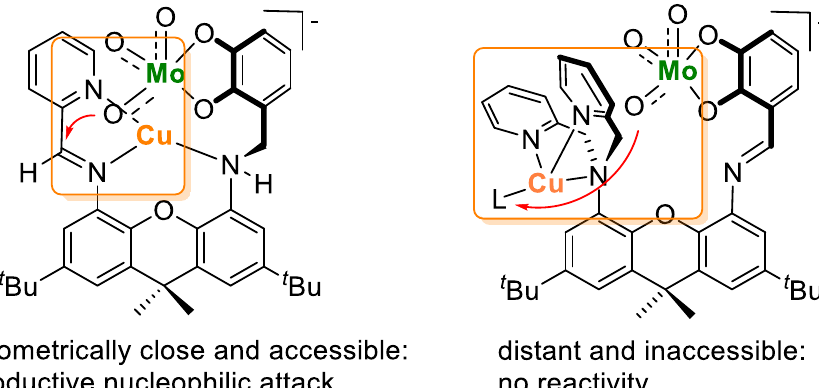
Figure 2. Comparison of the accessibility of Cu(I)-bound substrate to the nucleophilic attack by Mo- oxo in two different xanthene-based heterodinucleating systems